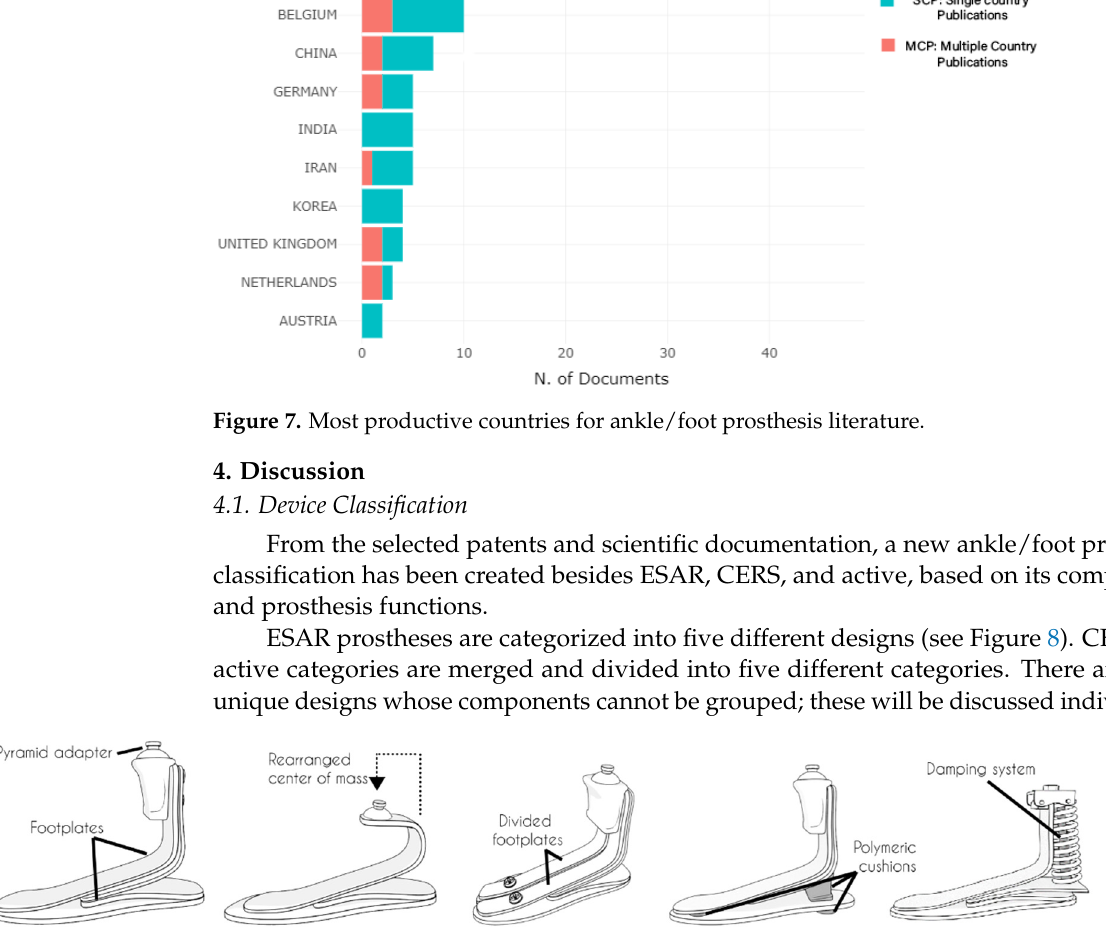
Figure 9. ( A ) Multiple plates prosthesis, ( B ) Single spring prosthesis by Kim Sa Yeop [74].